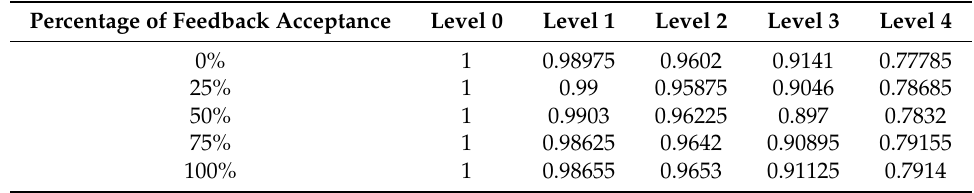
Table 4. User trust levels concerning efficiency when the devices’ error increases with the task level and the user is cautious.